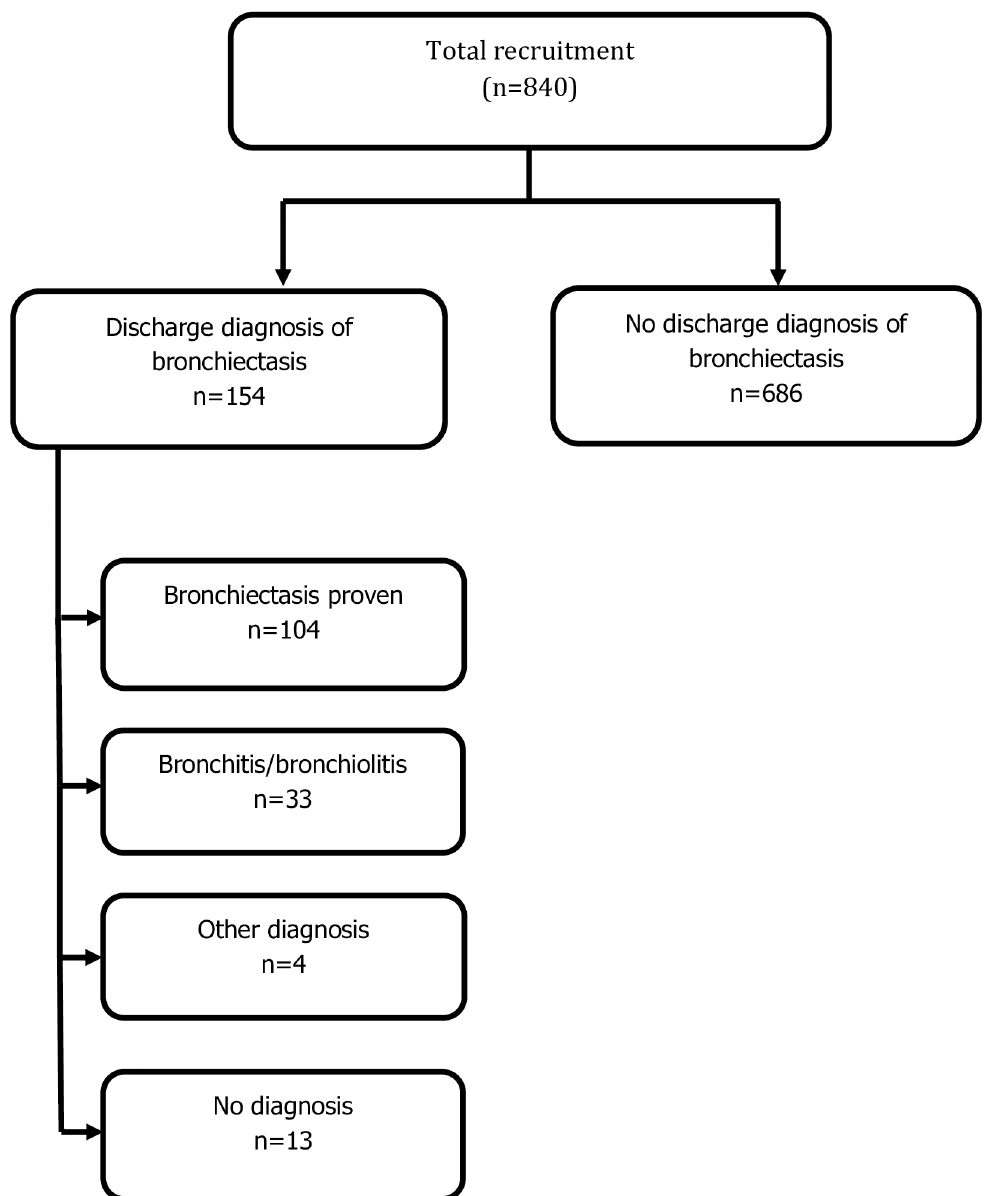
bronchiolitis in 33 cases (bronchitis alone, 20; bronchitis/bronchiolitis, 12; bronchiolitis alone, 1). Other diagnoses included emphysema (3) and pulmonary embolus (1). No cause of chronic cough could be found in 13